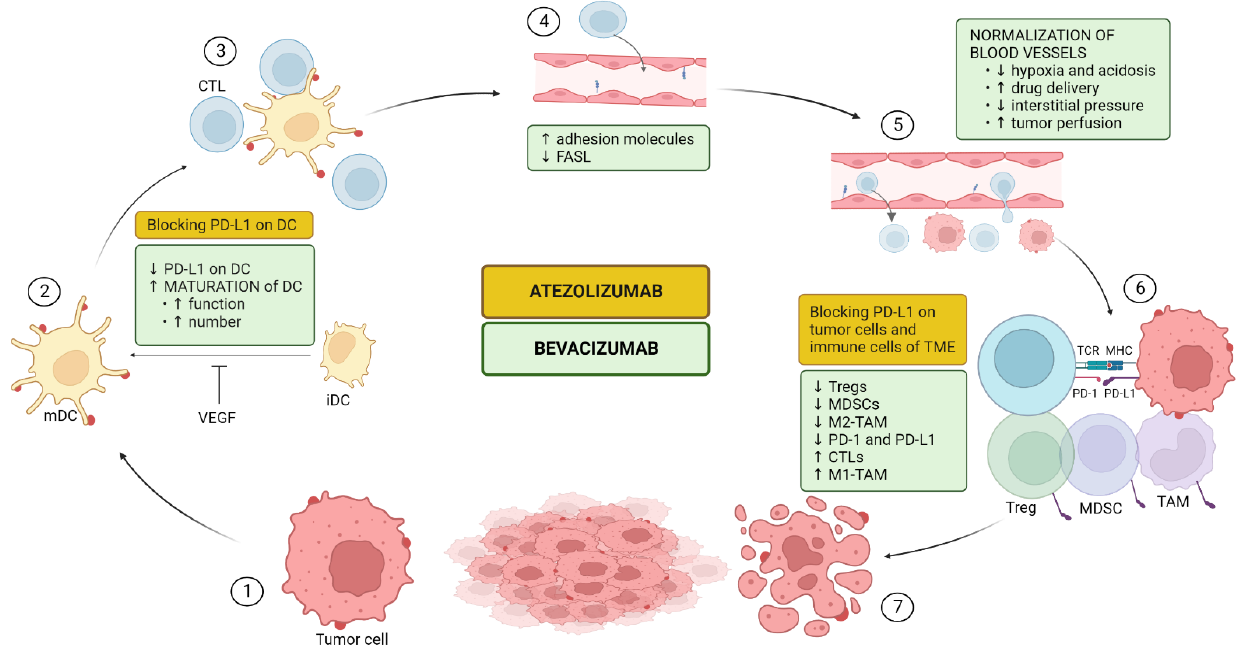
Figure 2. Effects of atezolizumab and bevacizumab upon the cancer-immunity cycle (CIC): enhancing anticancer immunity by creating a more immunoactive environment. Antigen presentation via DCs is upregulated due to bevacizumab-induced maturation of DCs and to blocking or decreasing expression of PD-L1 on DCs. As a result, more CTLs are activated. Bevacizumab facilitates the infiltration of these activated CTLs into the blood vessel by increasing adhesion molecules and by ‘vascular normalization’. This latter generally means a less chaotic organized and leaky endothelium leading to a less hypoxic and acidic tumor microenvironment (TME), less interstitial pressure, and more drug delivery and tumor perfusion. Furthermore, bevacizumab decreases Fasl, an antigen that can induce apoptosis of CTLs. In the tumor, the activated CTLs will evade the vessel and kill cancer cells in the presence of an immunofavorable TME. Bevacizumab will enhance that environment by, directly and indirectly, increasing immunoactivating cells (CTLs and M1-TAMs) and decreasing immunosuppressor cells (Tregs, MDSCs, and M2-TAMs). Finally, atezolizumab and bevacizumab will both respectively block or decrease PD-(L)1 on tumor cells and the immune cells of the TME. Both therapies play a role in augmenting cancer antigen presentation, activation of T-cells, and recognition of cancer cells by CTLs; bevacizumab additionally augments trafficking and infiltration of T-cells to the tumor. Taken together, these therapies synergistically create a more immunoreactive TME. Steps of the CIC: 1. Release of cancer antigens; 2. Cancer antigen presentation; 3. Priming and activation of T-cells; 4. Trafficking of T-cells to the tumor; 5. Infiltration of T-cells into the tumor; 6. Recognition of cancer cells by cytotoxic T-cells (CTLs); 7. Lysis of cancer cells. DC: dendritic cell; mDC: mature dendritic cell; iDC: immature dendritic cell; VEGF: vascular endothelial growth factor; FASL: